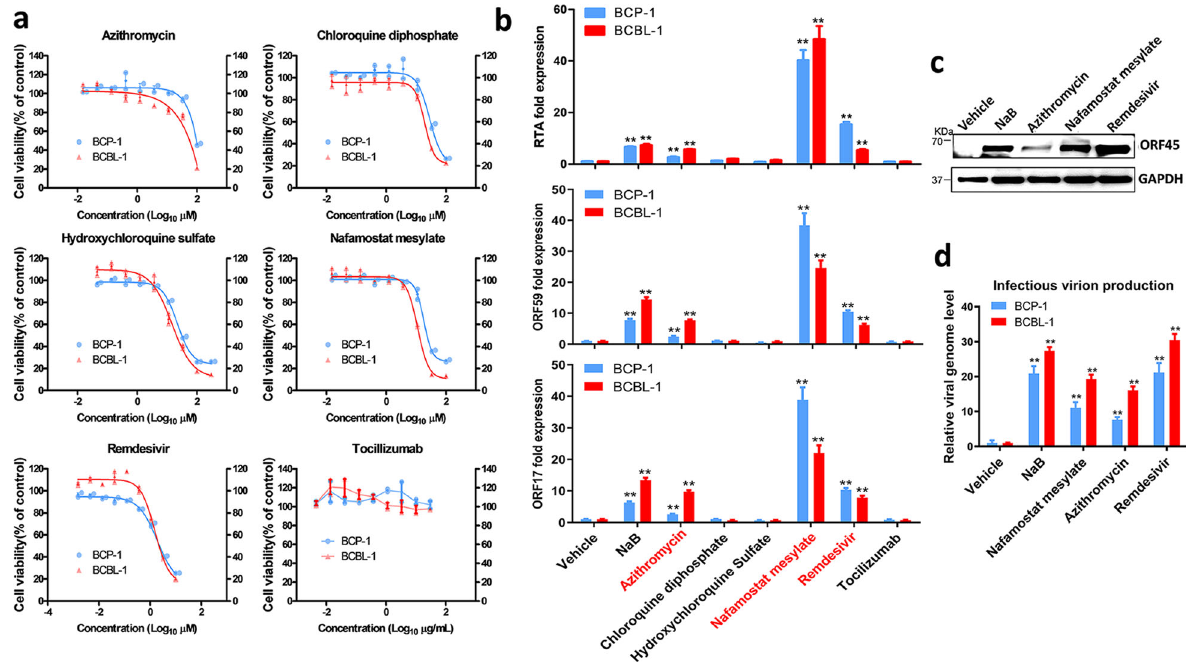
Fig. 3 The impacts of anti-COVID-19 drugs on the growth and viral gene expression of KSHV + tumor cells. a BCBL-1 and BCP-1 cells were treated with a dose range of 6 anti-COVID-19 drugs, for 72 h, then the cell proliferation status was examined using the WST-1 cell proliferation assays (Roche). b , c Cells were treated with Azithromycin (10 µ M), Chloroquine diphosphate (10 µ M), Hydroxychloroquine sulfate (10 µ M), Nafamostat mesylate (10 µ M), Remdesivir (3 µ M), Tocilizumab (20 µ g/mL), respectively, for 72 h, then the transcripts of representative lytic genes were quanti fi ed by using qRT-PCR. Protein expression was measured by immunoblots. d The supernatants from drug-treated cells above were collected to infect naive HEK293T cells, then viral genome levels were quanti fi ed by using qPCR with Lana-speci fi c primers. The sodium butyrate (NaB, 0.3 mM) was used as a positive control. Error bars represent S.D. for 3 independent experiments, ** p < 0.01 (vs the vehicle control).